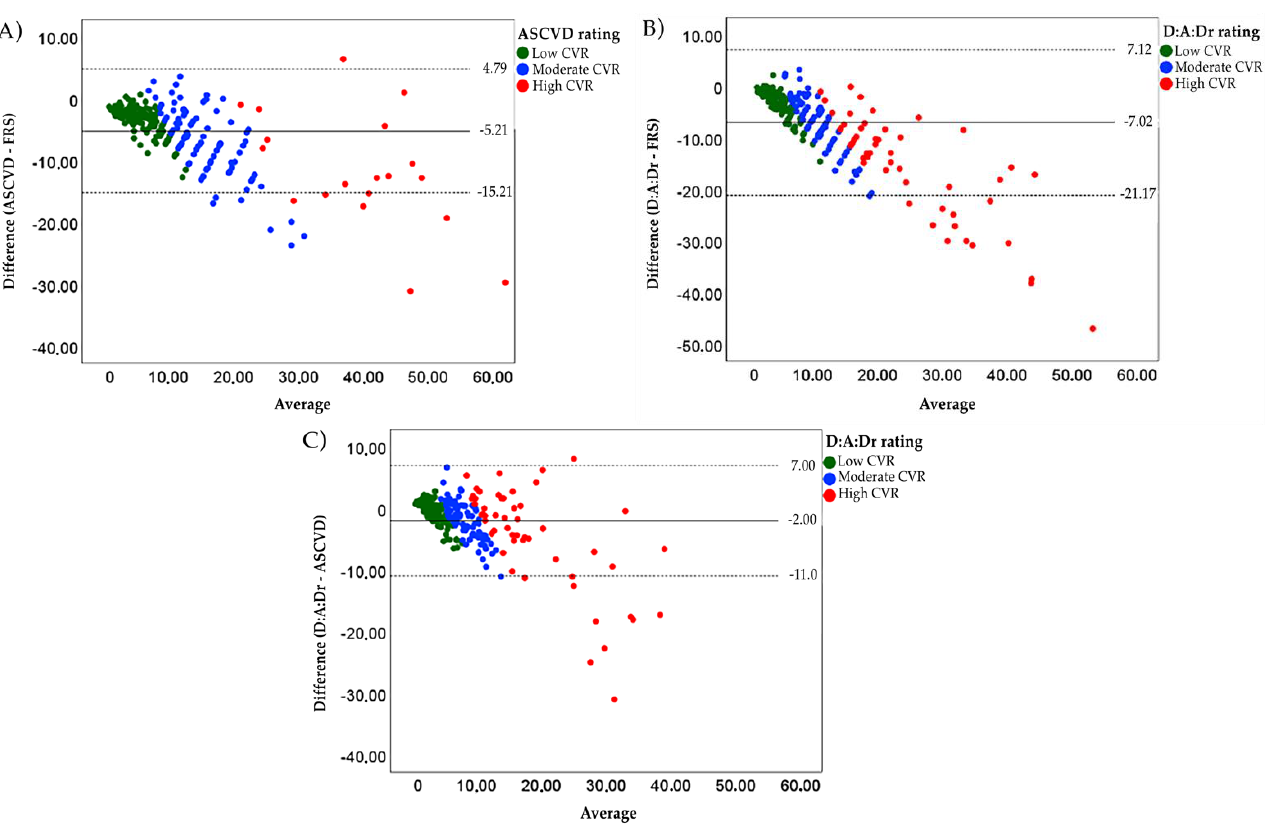
on average 5.21% ( ± 5.00%) lower than FRS; the limits of the difference were − 15.21% and 4.79%. ( B ) The D:A:Dr risk score was on average 7.02% (±7.22%) lower than FRS; the limits of the difference